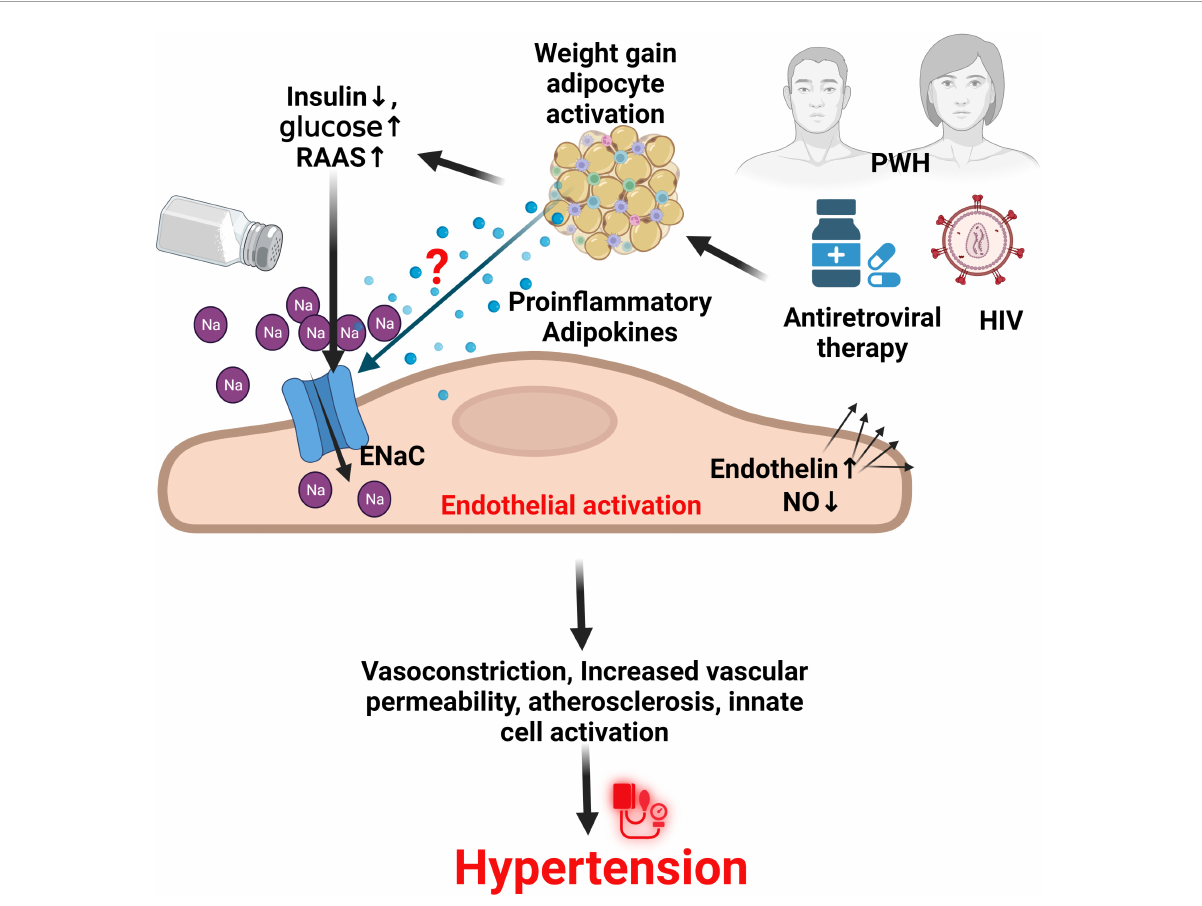
FIGURE3 ENaC in endothelial cells and the role of HIV and ART in hypertension. It is thought that HIV infection and use of antiretroviral therapy especially dolutegravir, synergizes with other factors such as increased glucose, reduced insulin action and production, and activation of the renin angiotensin aldosterone system (RAAS) through unknown mechanisms to increase the activity of the endothelial sodium channel (ENaC) on activated endothelial cells. This results in several effects that contribute to hypertension. NO, nitric oxide; PWH, persons with HIV; Na, sodium; HIV, human immunodeficiency